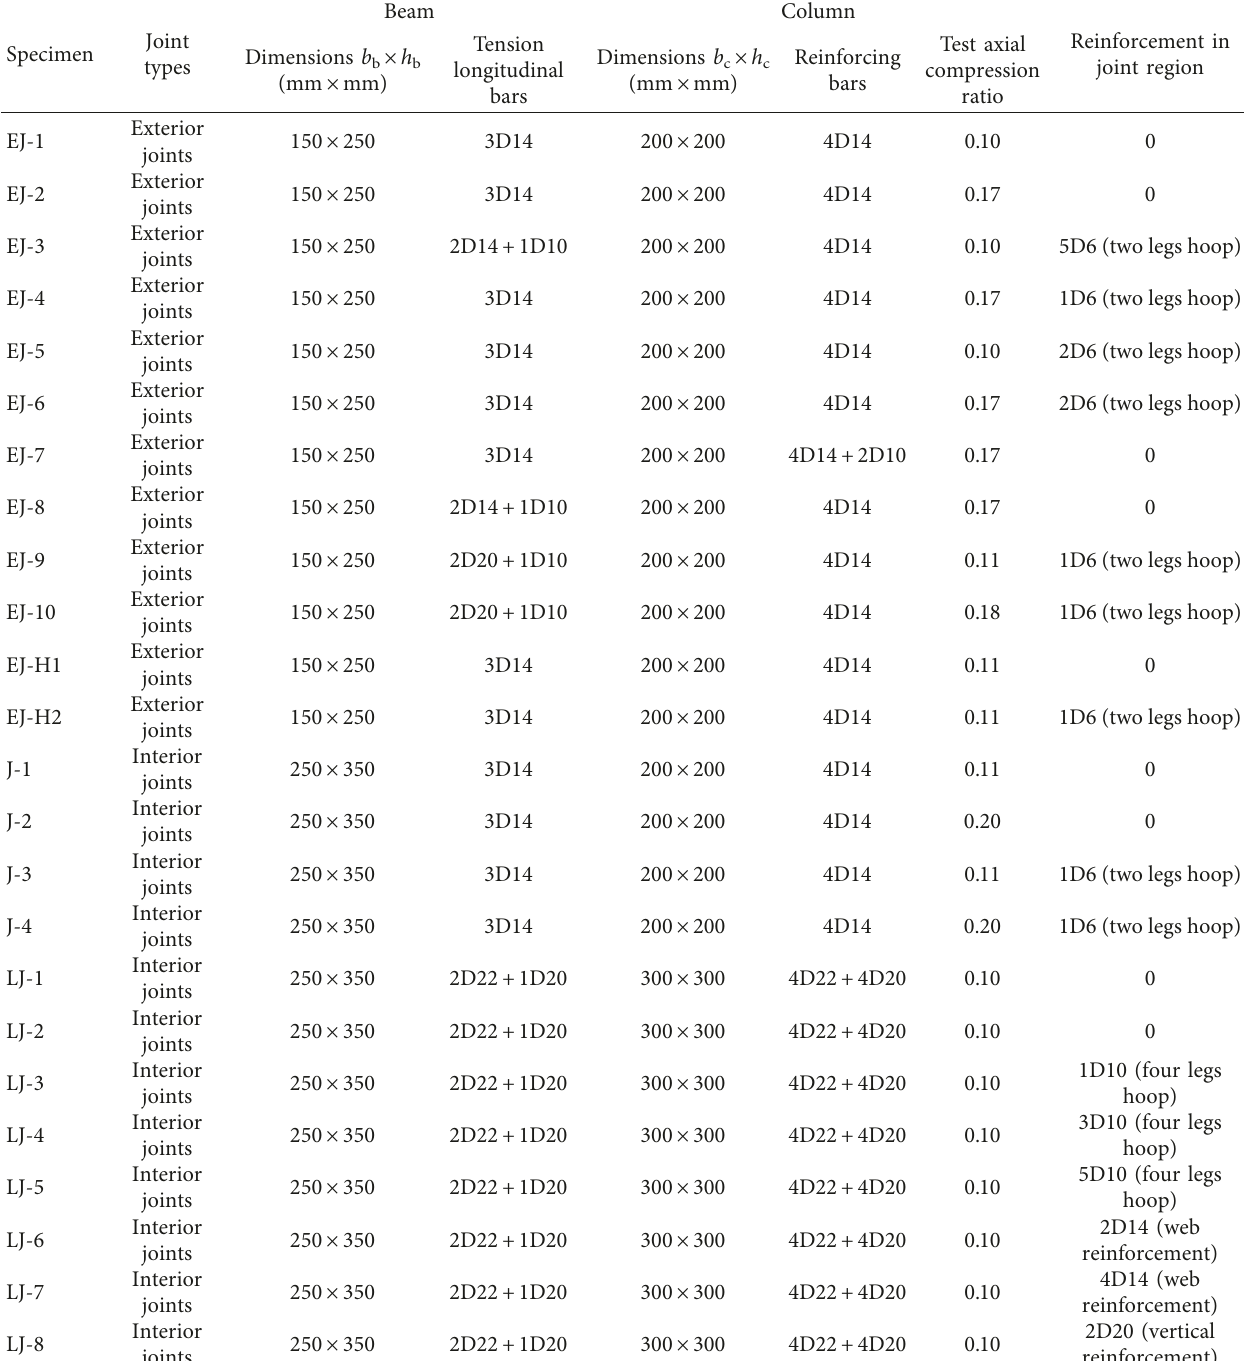
Table 1: Specimen